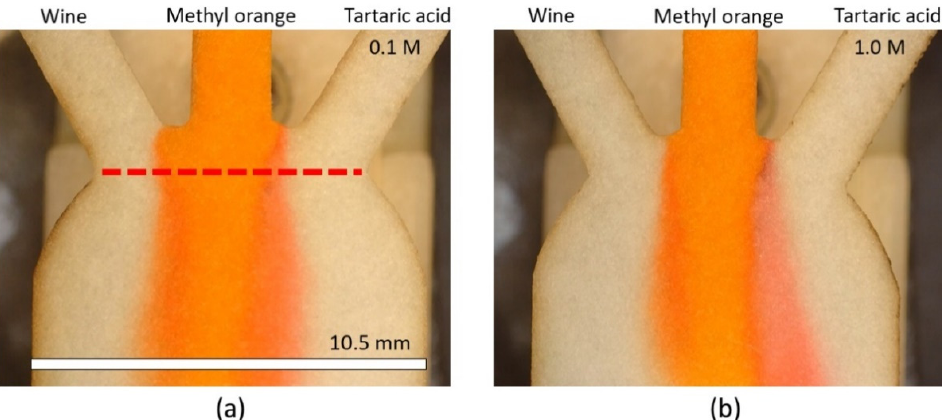
Figure 8. Visual comparison of diffusion development in Whatman 40 paper substrate at 120 s after